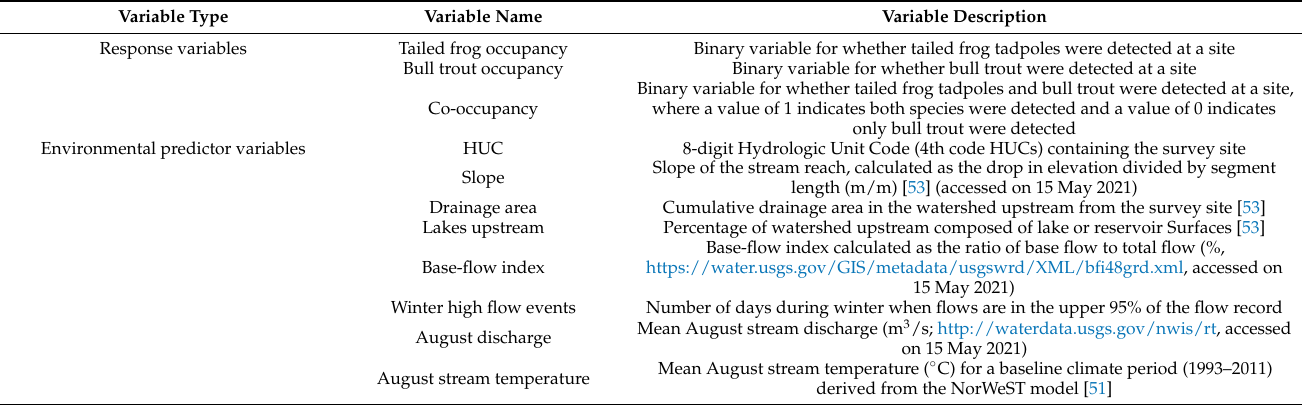
Table 1. Variables used in the occupancy models for bull trout and tailed frogs across 2829 sites. All species detections were based on observations from three-pass electrofishing surveys. See Isaak et al. [42] and Table 1 in Isaak et al. [51] for rationale for inclusion of variables in bull trout and tailed frog occupancy models (except where